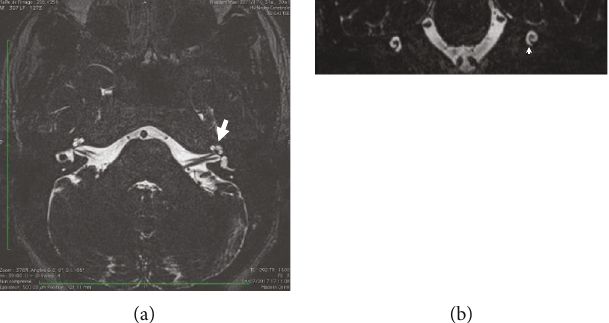
Figure 4: Magnetic resonance imaging of the temporal bone: axial (a) and coronal (b) CISS 3D slices showing a signal of discreetly lower intensity in the left cochlea compared to the right one.